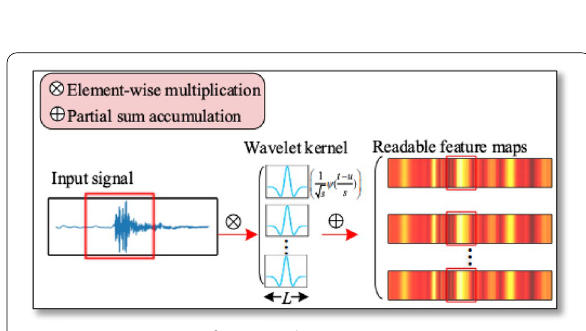
Figure 21 Operation of CWConv layer